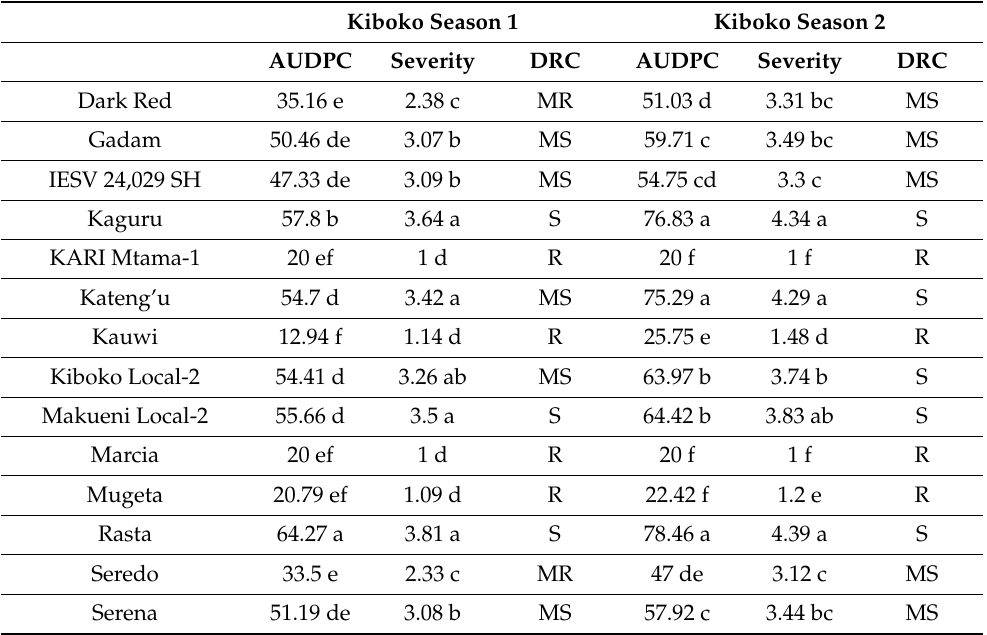
Table 6. Area under the disease progress curve (AUDPC), disease severity scores and disease reaction types in 14 sorghum genotypes following inoculation with Colletotrichum sublineola under field conditions at KALRO-Kiboko.